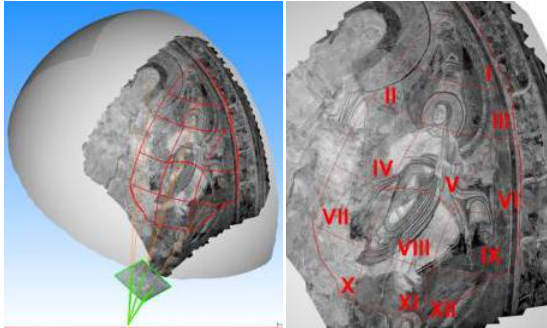
Figure 17 Texturing phase (left) and the 12 different orthoprojected parts (right).